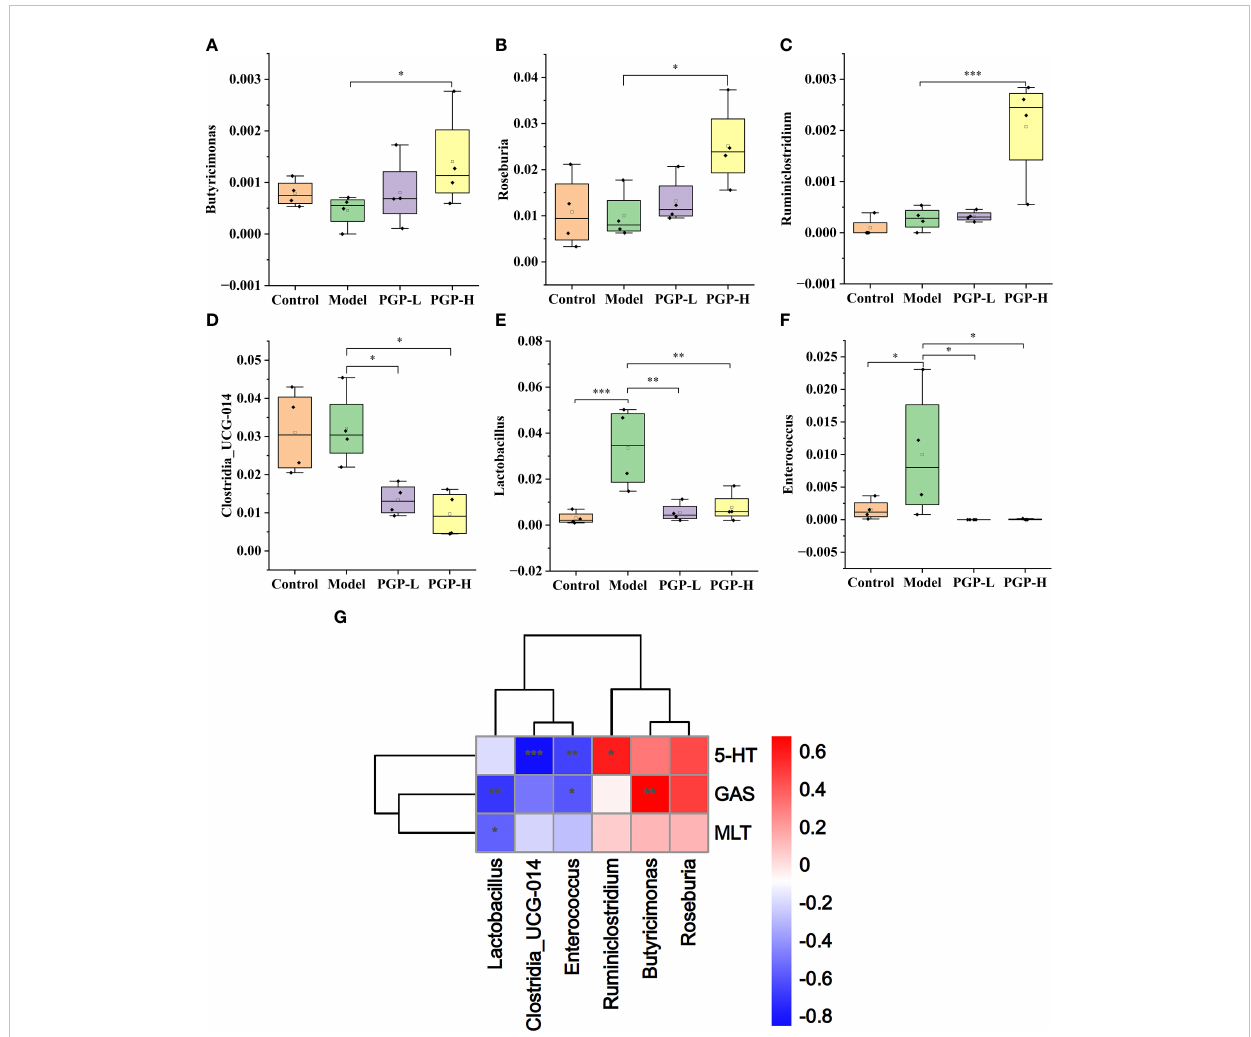
FIGURE 7 Relative abundance of (A) Butyricimonas ; (B) Roseburia ; (C) Ruminiclostium ; (D) Clostridia UCG-014 ; (E) Lactobacillus ; and (F) Enterococcus . (G) Spearman ’ s correlation analysis of the intestinal microbiota and constipation-related physiochemical parameters in a heatmap. * p < 0.05, ** p < 0.01, *** p <